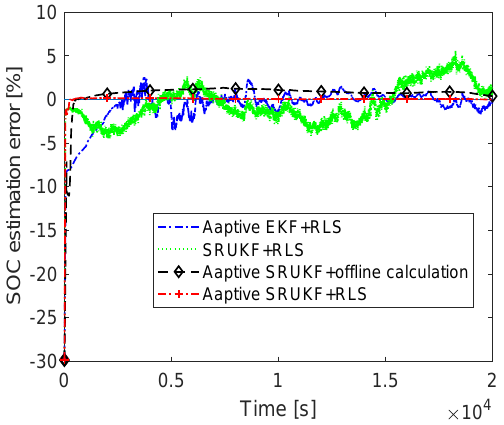
Figure 10. SOC estimation error of the